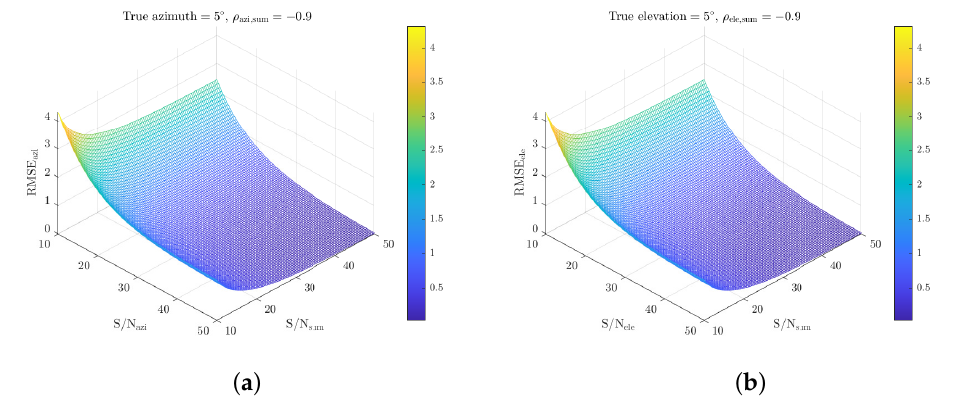
Figure 10. RMSE for difference channel SNR and sum channel SNR ( θ azi , θ ele = 5 ◦ , ρ azi,sum = − 0.9).